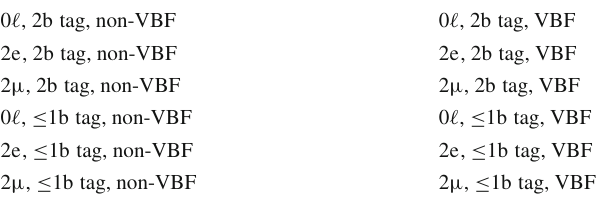
Table 1 List of the 12 event categories used in the